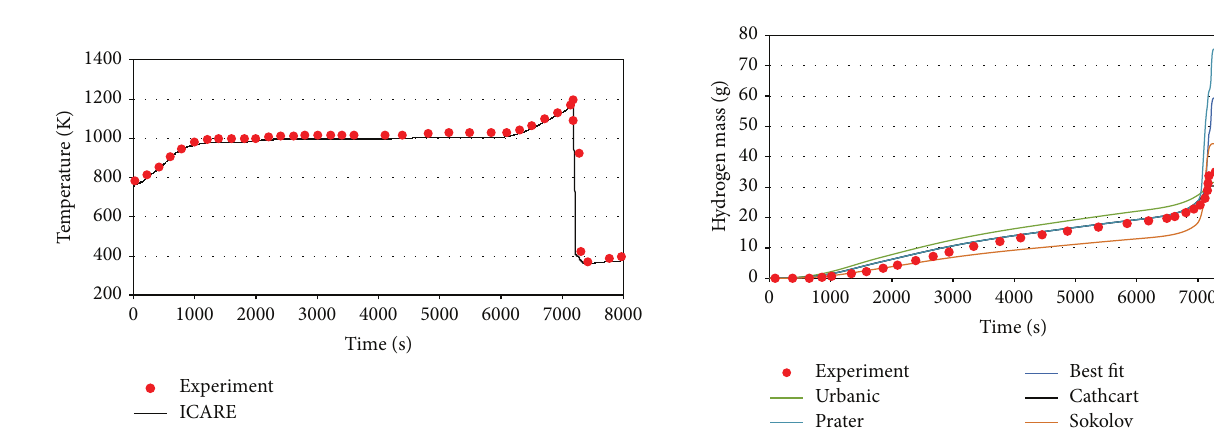
Figure 16: Nodalization scheme of QUENCH test, developed using ASTEC code ICARE module.